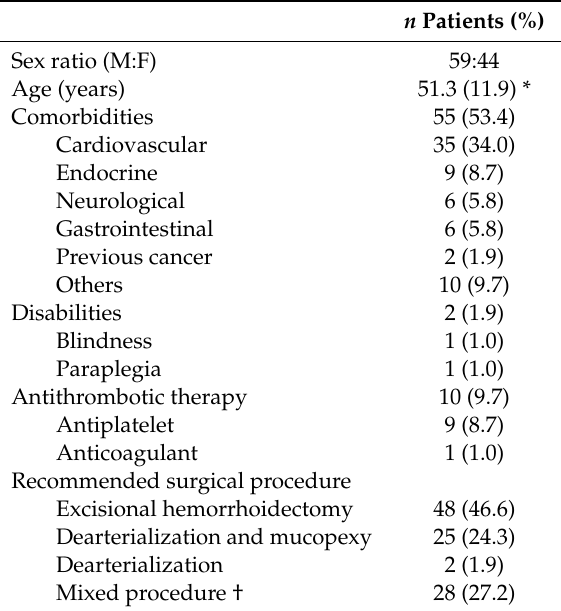
Table 1. Patients’ baseline